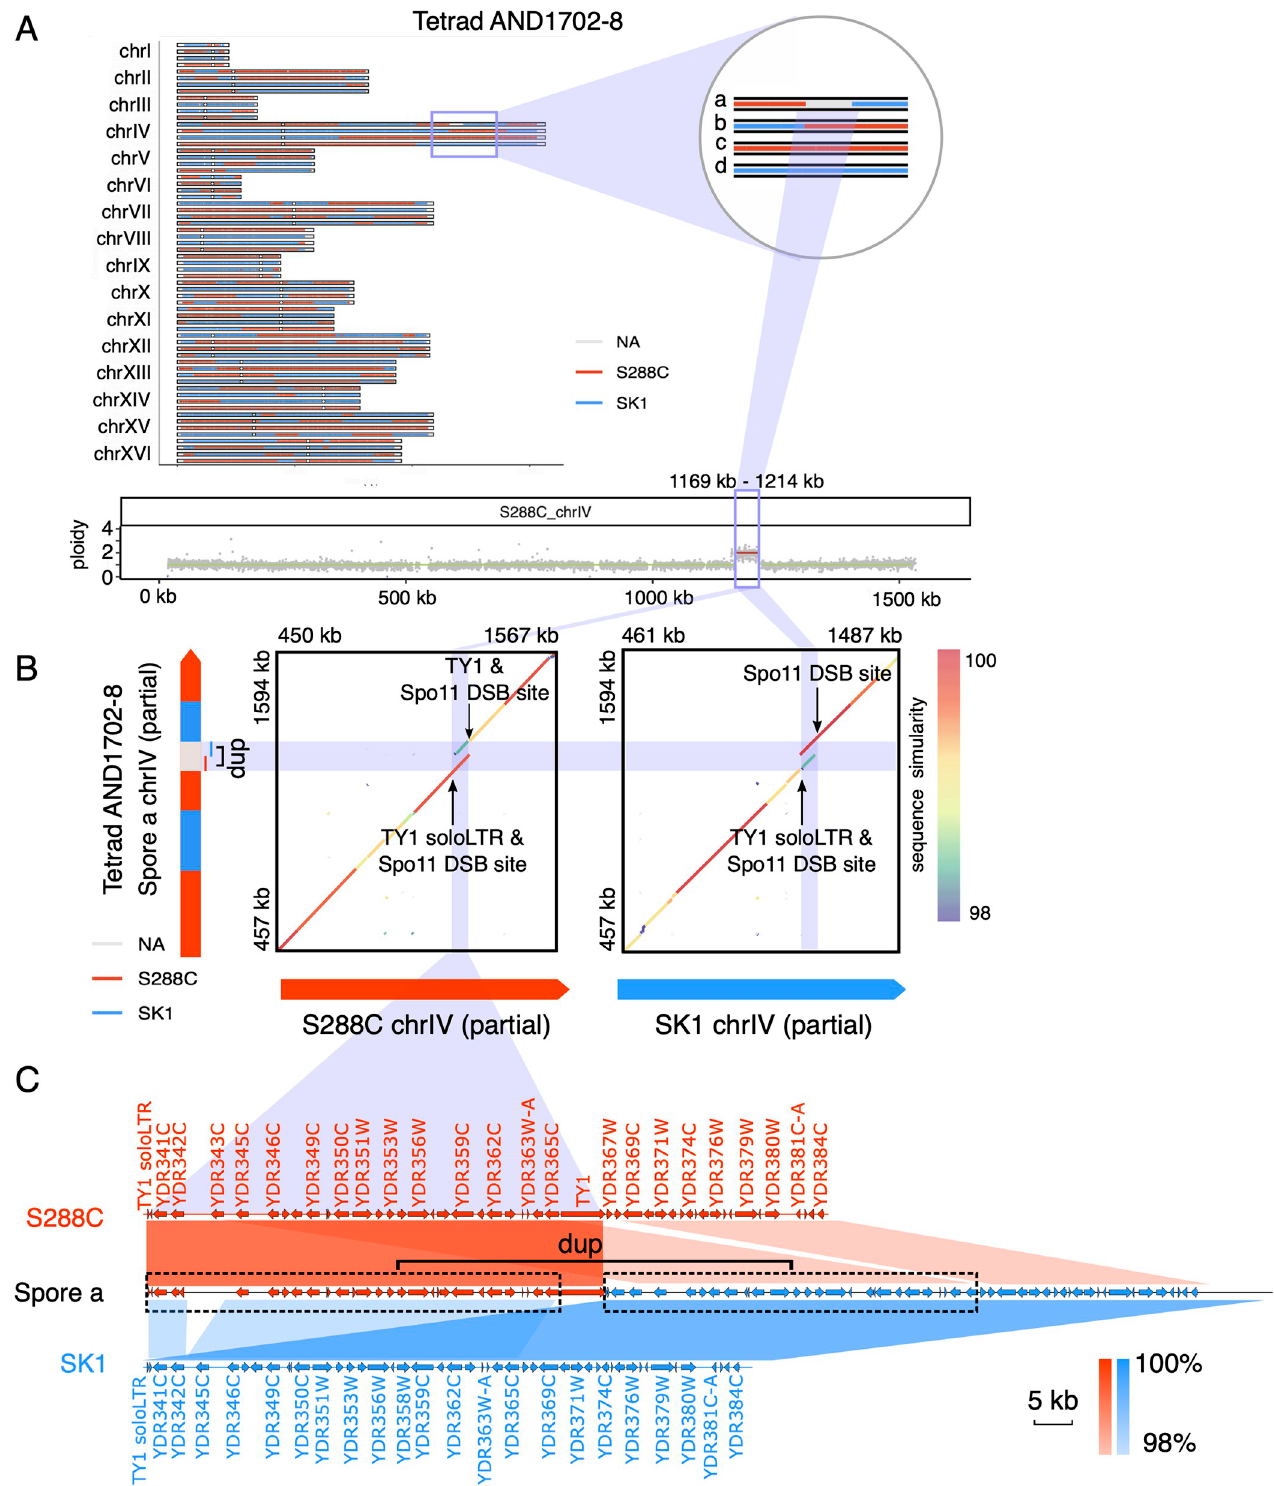
Fig 7. RecombineX enables the discovery of complex structural rearrangements in the gamete AND1702-8:a. (A) A 45-kb CNV identified by RecombineX in the gamete AND1702-8:a. (B) Genome sequence comparison between AND1702-8:a and its crossing parents (S288C and SK1) for the focal structural rearrangement and its flanking regions. Two genome comparison dotplots are shown for AND1702-8:a vs. S288C (left) and AND1702-8:a vs. SK1 (right) respectively, with their per-base sequence similarities depicted in rainbow colors. Previously annotated TY transposable element and Spo11 DSB